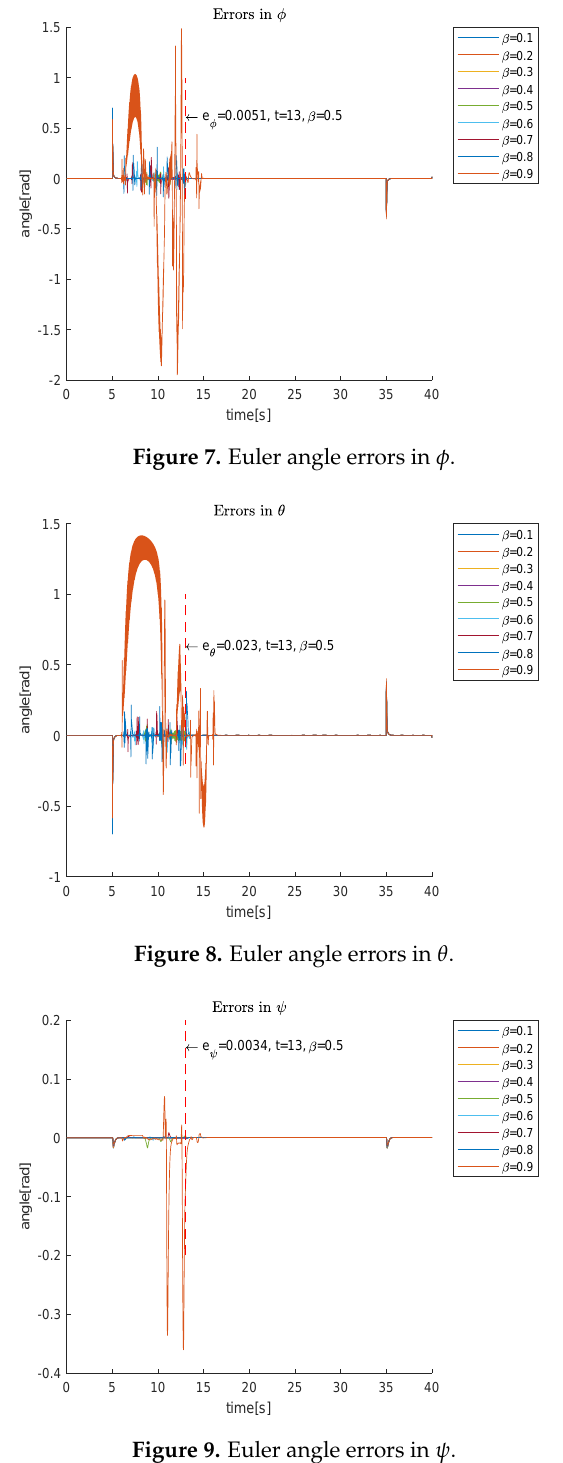
Figure 9. Euler angle errors in ψ